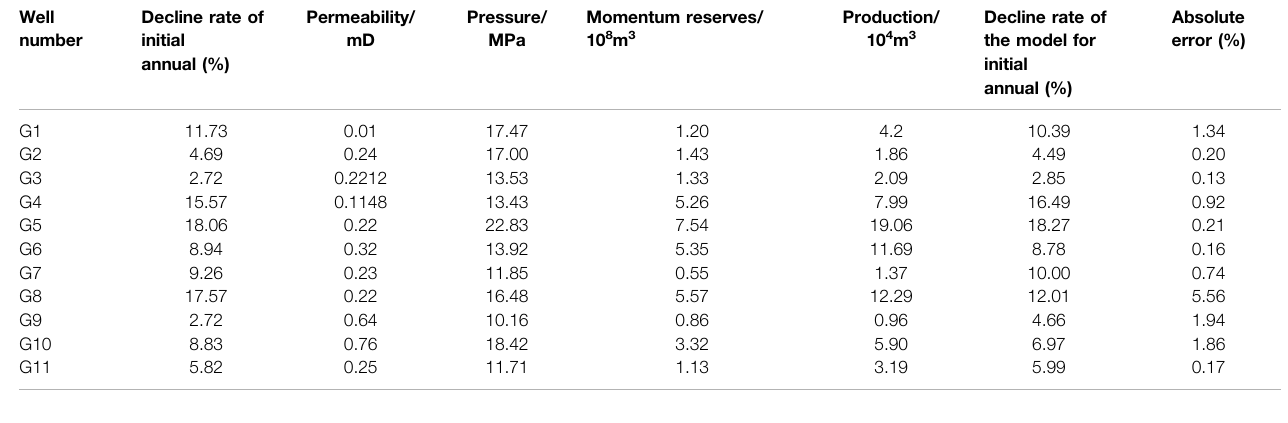
TABLE 3 | Response surface model veri fi cation table.